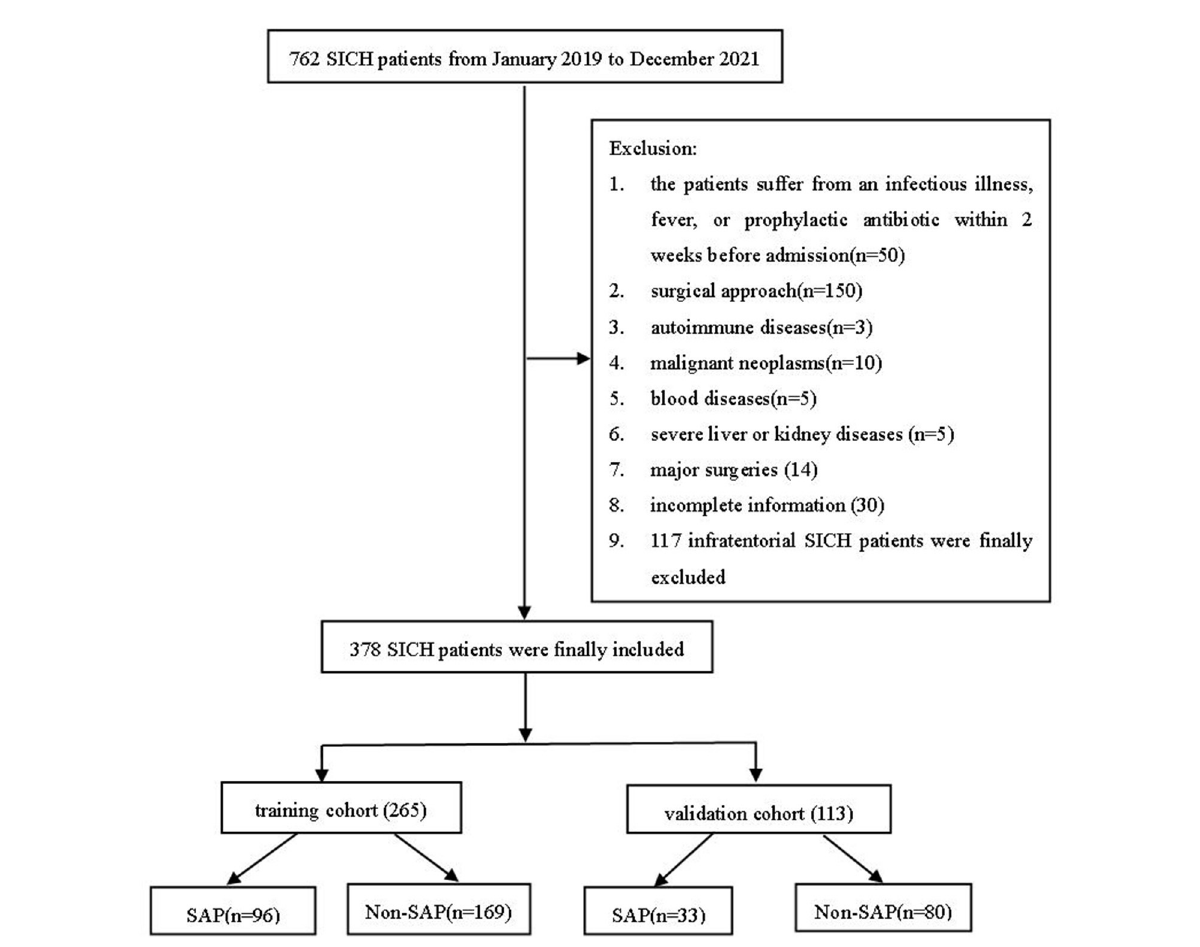
FIGURE1 A flowchart of the present study. SICH, spontaneous intracerebral hemorrhage; SAP, stroke-associated